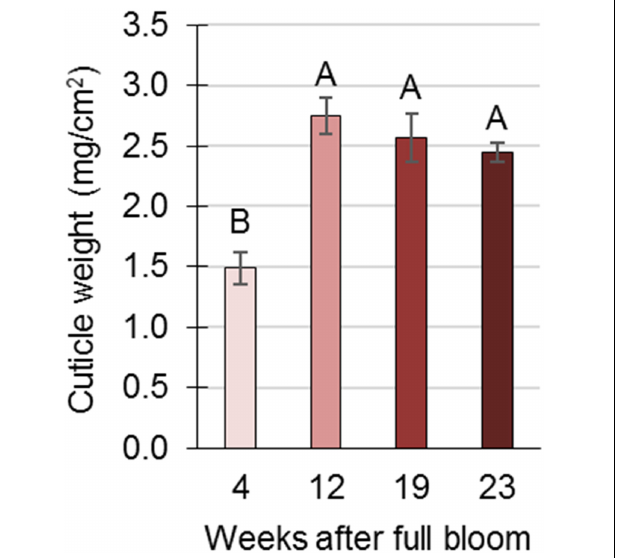
FIGURE 4 | Cuticle determination in pomegranate fruit skin during development in 2014. Cuticle membrane was purified from underlying epidermal and parenchyma cells by enzymatic lysis in cellulose and pectinase solution and its weight (mg/cm 2 ) was calculated as the average of three replicate fruits ± SE. Data were analyzed for statistical significance by Student’s t -test. Mean values with different letters differ significantly at P <